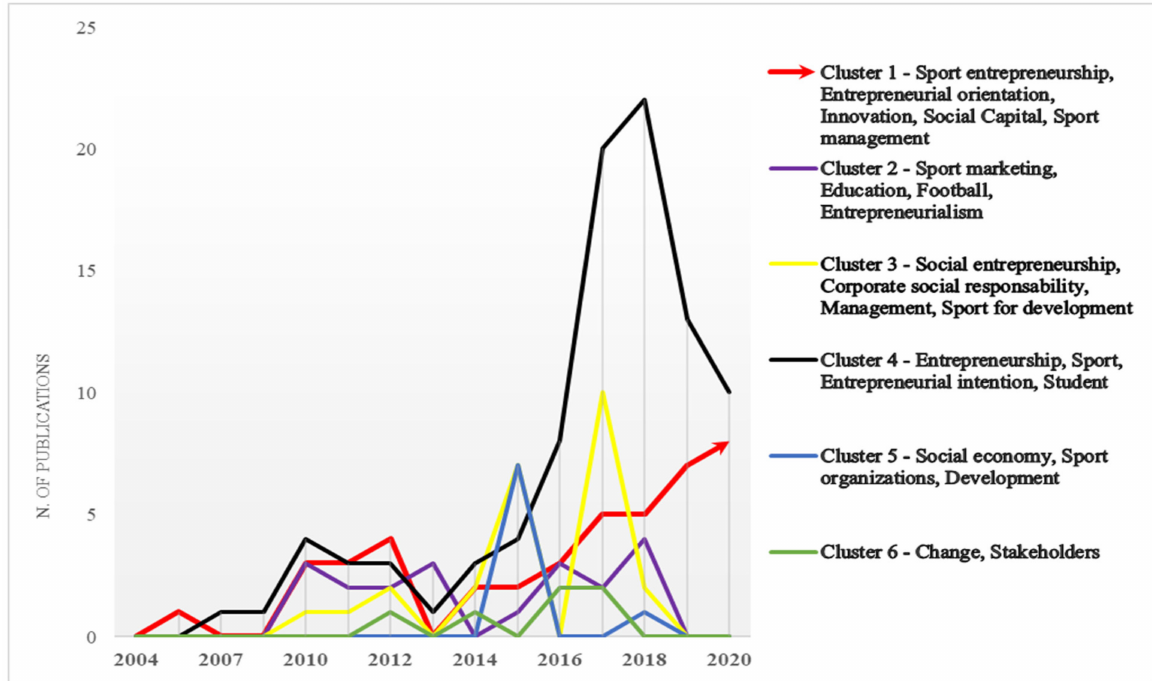
Figure 3. Evaluation of scientific publications per